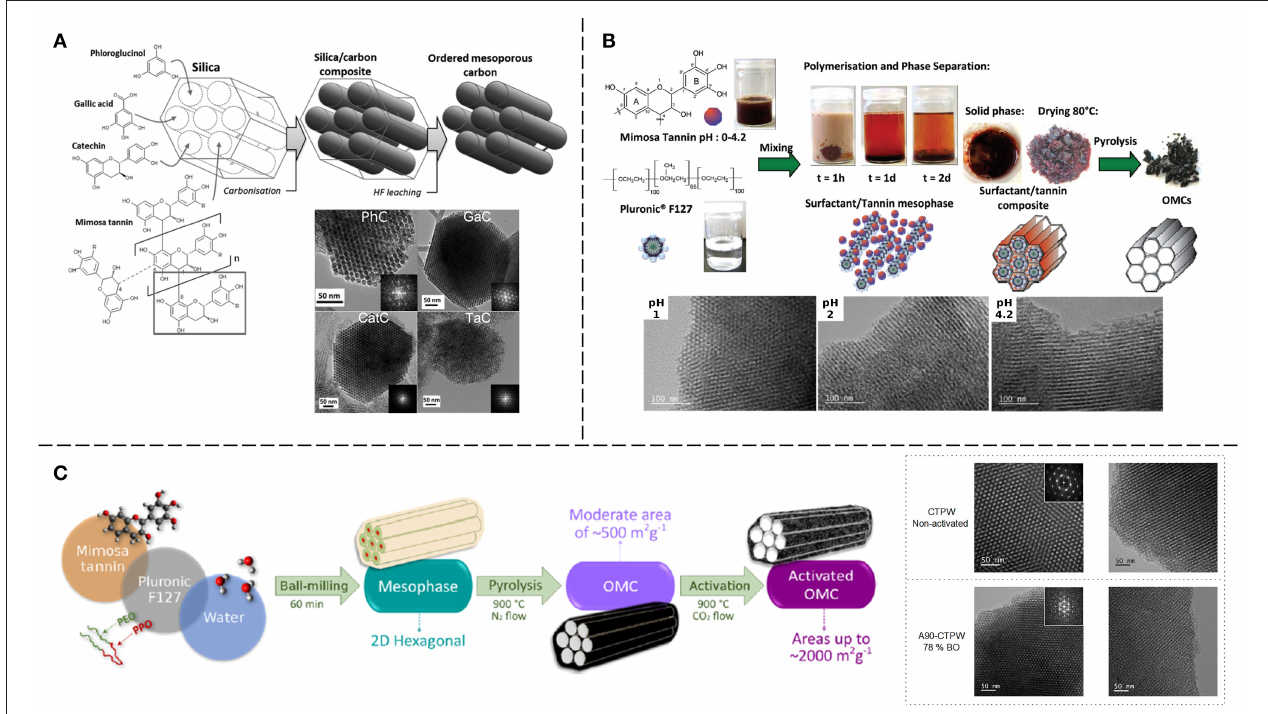
FIGURE 11 | Synthesis of OMCs from mimosa tannin by: (A) hard-templating, also carried out using other biomass-derived phenolic molecules (Adapted with permission of Elsevier, from Sanchez-Sanchez et al., 2017a; permission conveyed through Copyright Clearance Center); and soft-templating through (B) phase separation (Adapted from Braghiroli et al., 2016 by permission of The Royal Society of Chemistry) and (C) mechanosynthesis (Adapted with permission from Castro-Gutiérrez et al., 2019. Copyright 2019 American Chemical